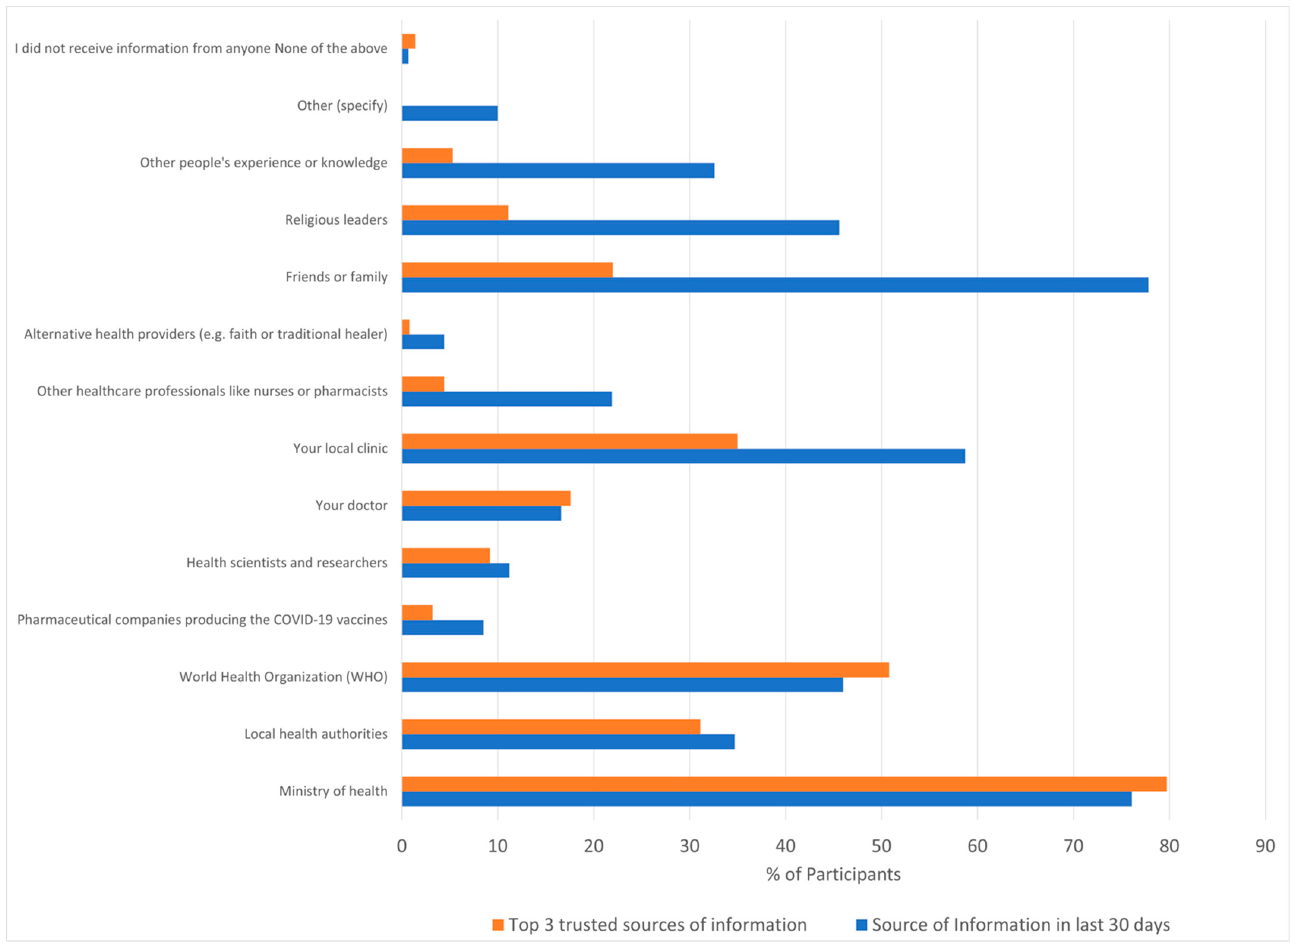
Figure 2. Sources and Trusted sources of information. Participants were asked “In the past 30 days, who have you received information from about COVID-19?” multiple responses were allowed (Green). Participants were subsequently asked “What are your top three sources of trusted information about COVID-19 vaccines?” (Red—only three responses allowed).